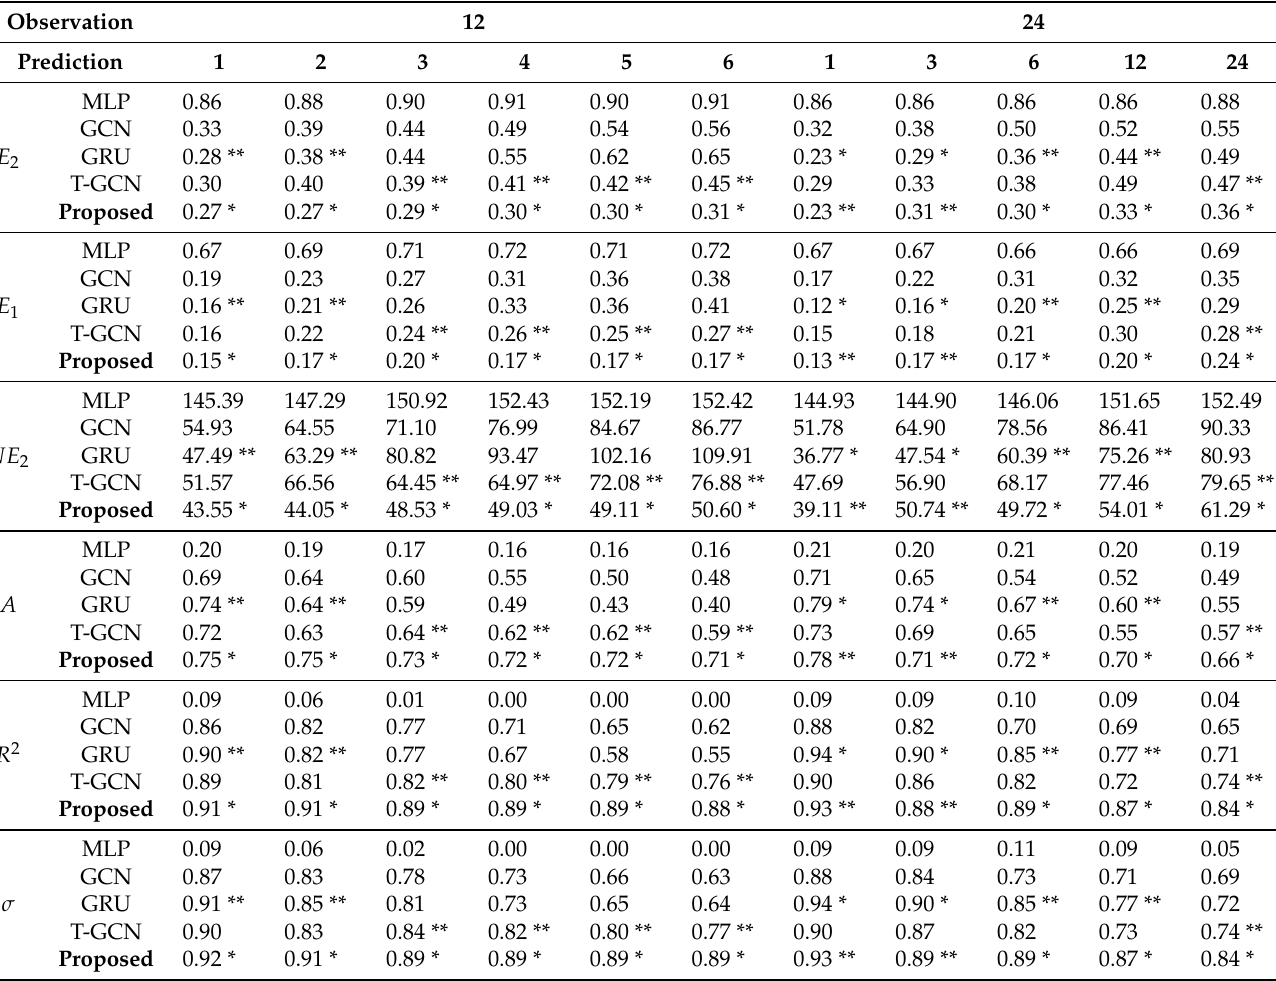
Table 3. The performance of the proposed and existing models according to the prediction and observation sequence lengths. The left and right sides of this table exhibit the model accuracy on cases that the observation sequence length is 12 and 24, respectively. Subsequently, each column presents changes in the model accuracy according to the prediction sequence length. Furthermore, * and ** denote models with the first and second best performance on each case and metric, respec- tively. The remaining hyper-parameters were set as N = 4 and θ V =